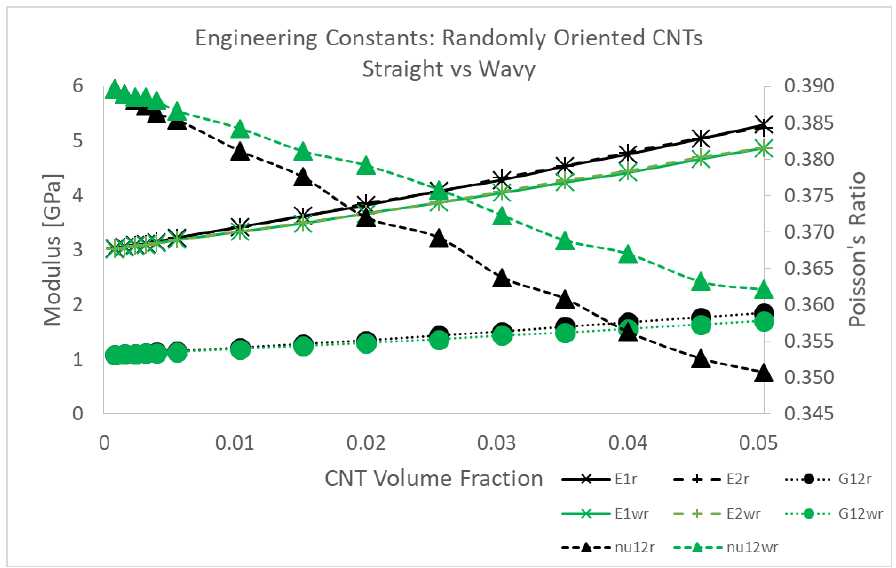
Figure 27. Comparison of engineering constant estimates E 1 , E 2 , G 12 and ν 12 between the randomly oriented straight case (r) and randomly oriented wavy case